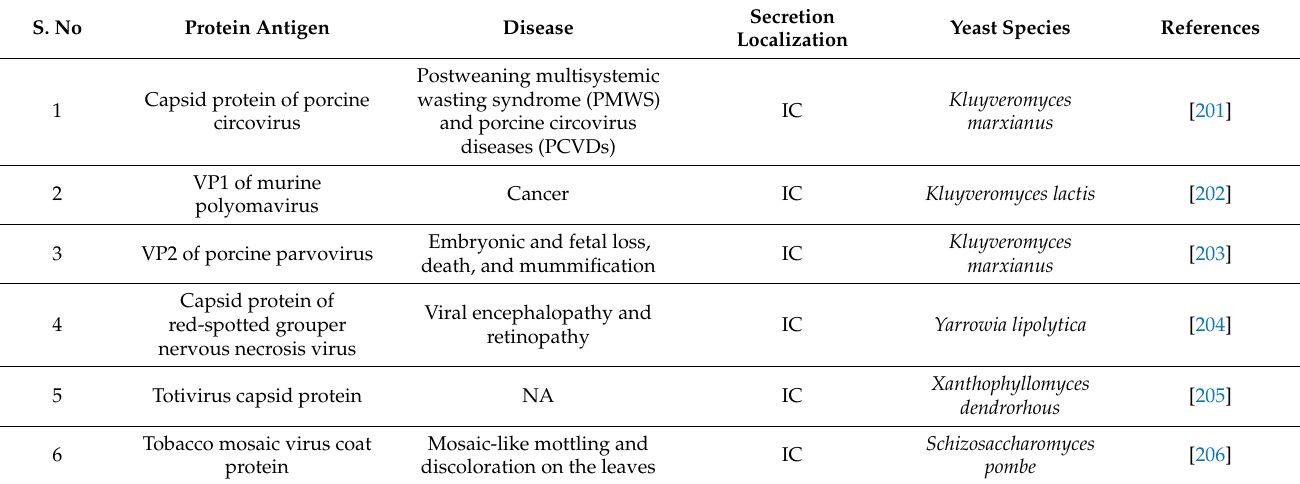
Table 5. Studies where yeast species (other than those in Tables 2–4) were used to generate